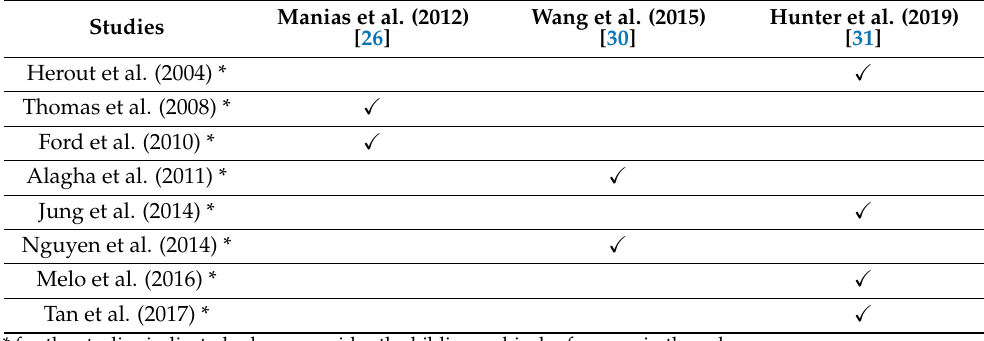
Table 4. Studies on educational interventions to prevent medication errors included in the systematic reviews included.